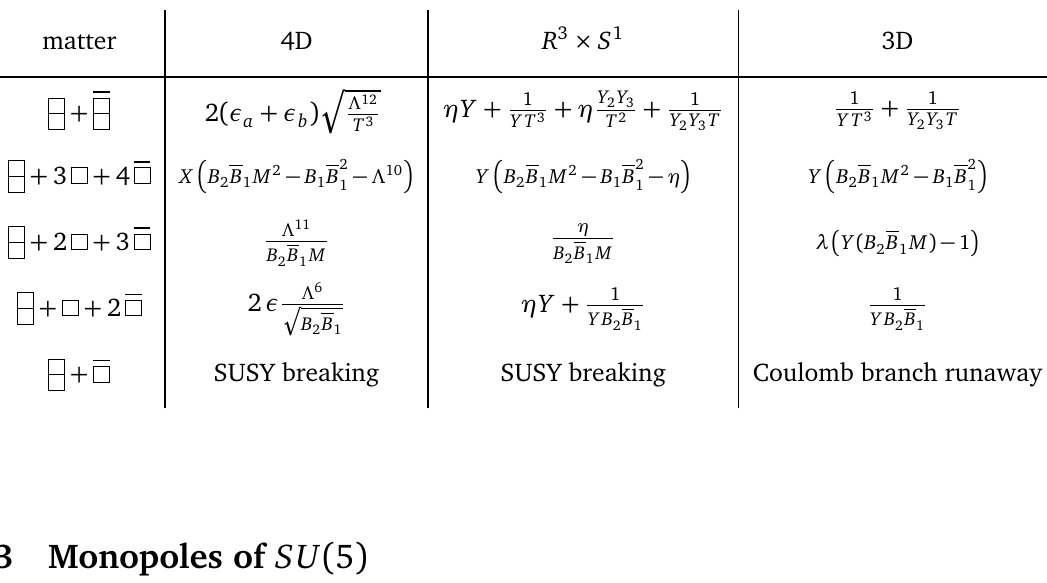
Table 2: Superpotentials for various mixed Higgs-Coulomb branches of SU ( 5 ) gauge theories on R 4 , R 3 × S 1 , and R 3 , where T = AA and ε = ± 1. The Coulomb branch operators Y are reviewed in Appendix B. The Lagrange multiplier field X enforces i the standard deformed moduli space constraint [ 26 ] , while the remaining symbols are intrinsic scales of the gauge theory.